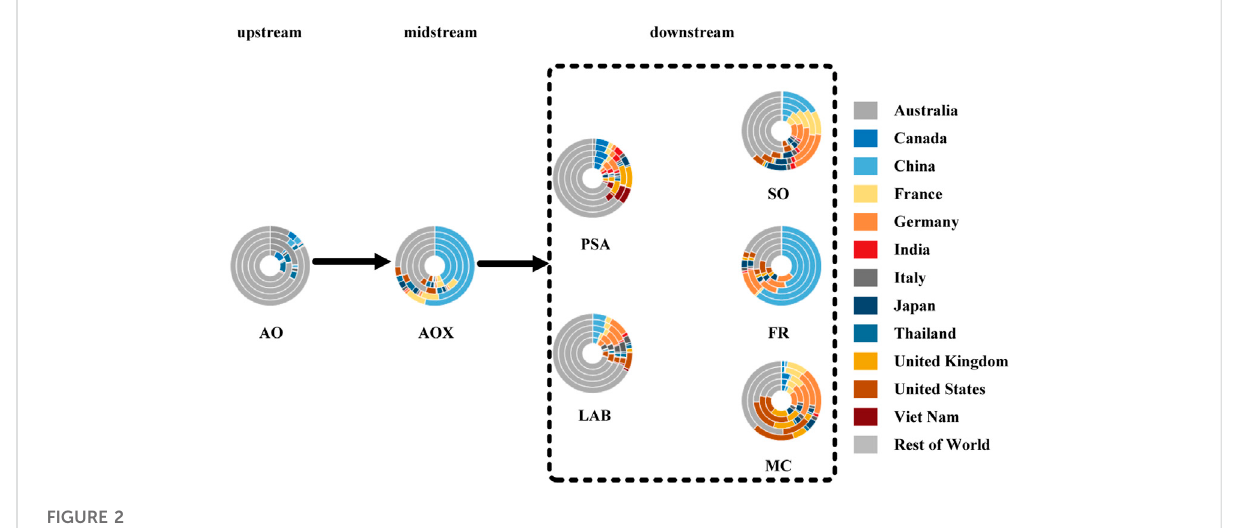
Supply structure in the global antimony industry